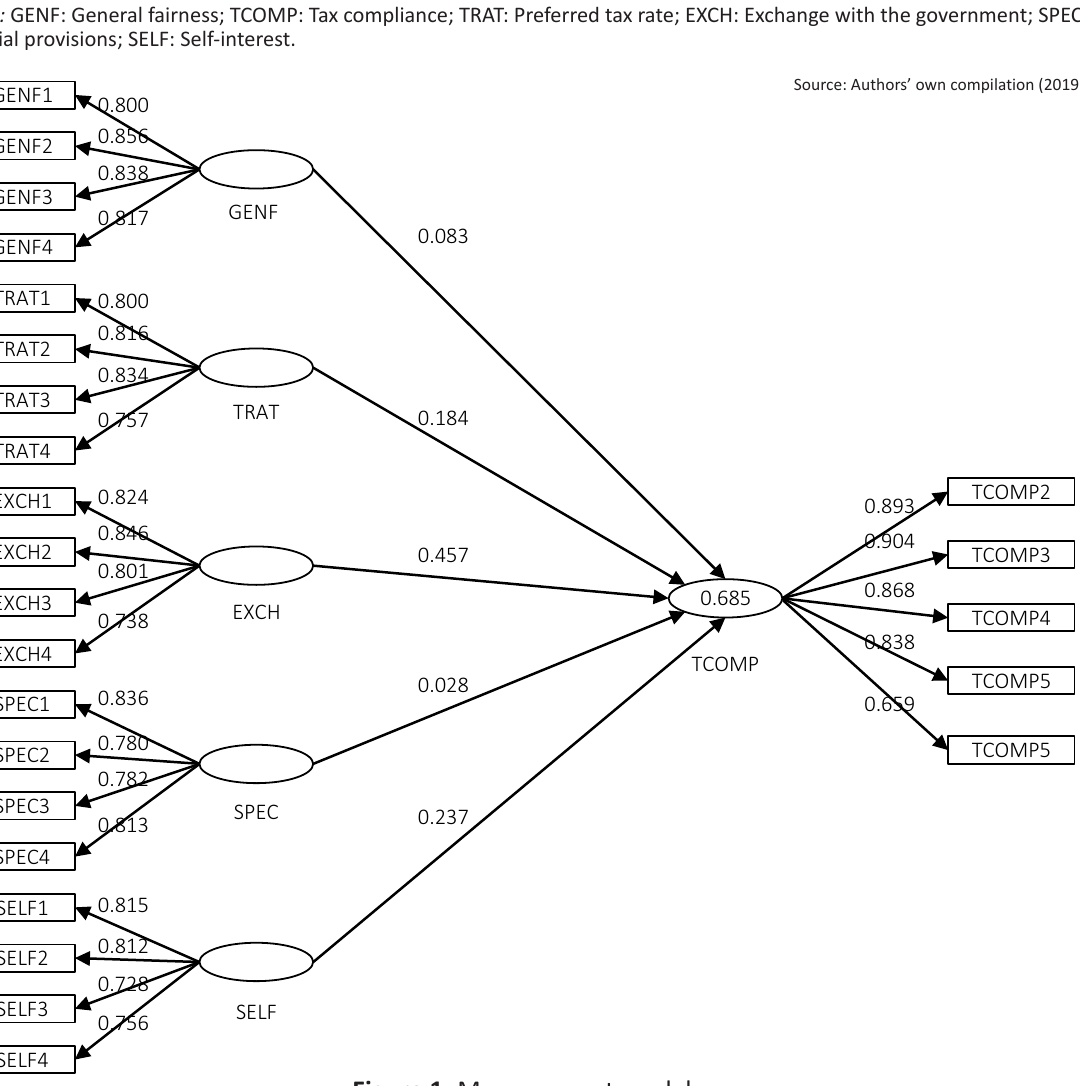
Figure 1. Measurement